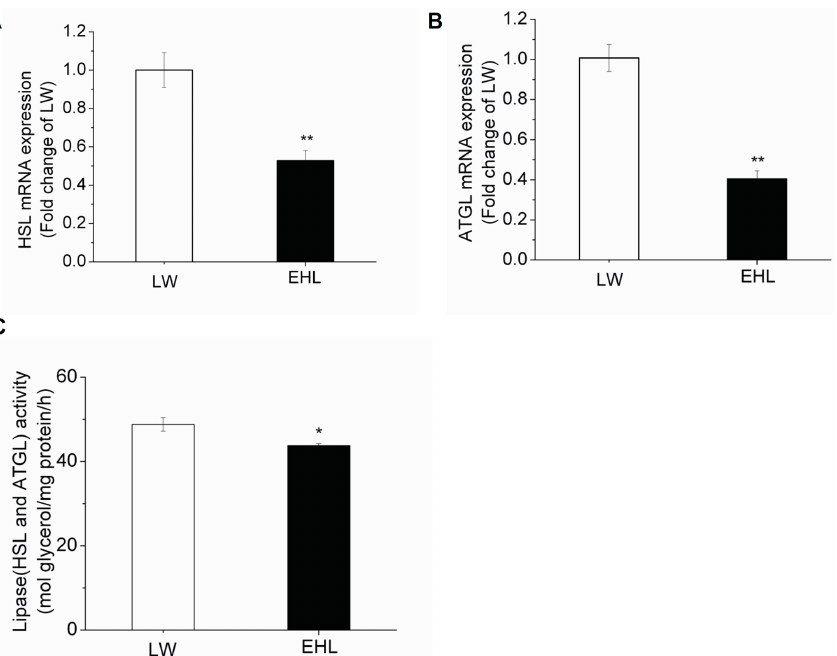
Figure 2. mRNA and protein expression of genes involved in lipolysis and lipases activity in the subcutaneous fat of LW and EHL pigs The values shown represent the mean ± standard error, n = 6; * P <0.05 vs. LW; ** P <0.01 vs. LW. (a) HSL mRNA expression, (b) ATGL mRNA expression and (c) Lipases activity (HSL and ATGL).